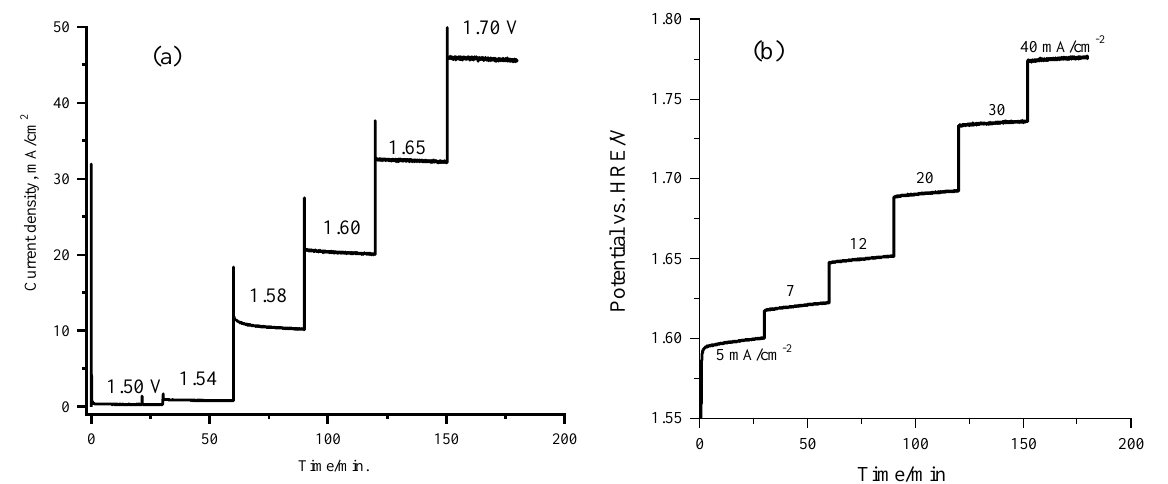
Figure 9. ( a ) chronoamperometry at different applied potential and ( b ) chronopotentiometry at a different applied current density of the Sr 2 CoO 3 F catalyst (loading 0.8 mg/cm 2 ) in 1.0 M NaOH electrolyte during prolonged water oxidation.